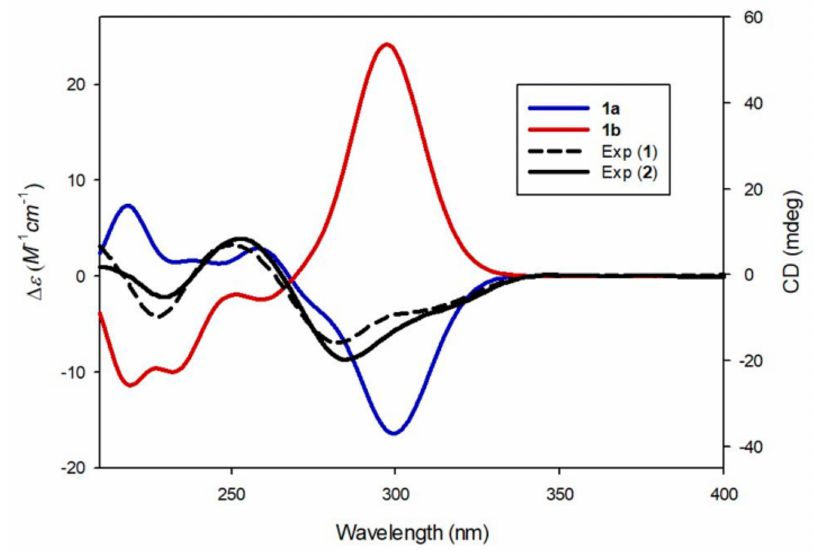
Figure 3. Experimental and calculated electronic circular dichroism (ECD) spectra of compounds 1 and 2